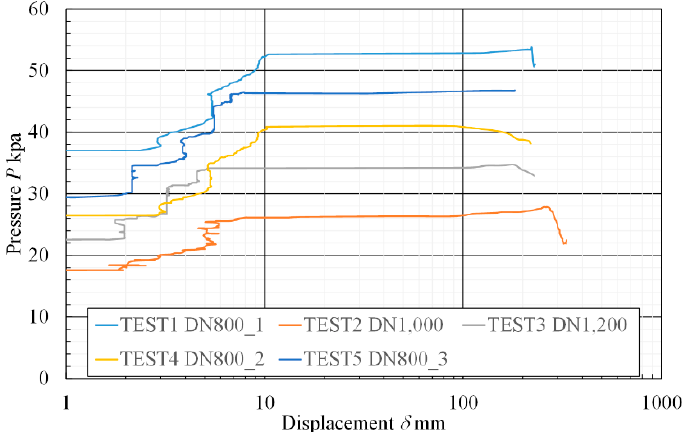
Table 2. Test result (buckling pressure of different lobes and gradient, Gr).